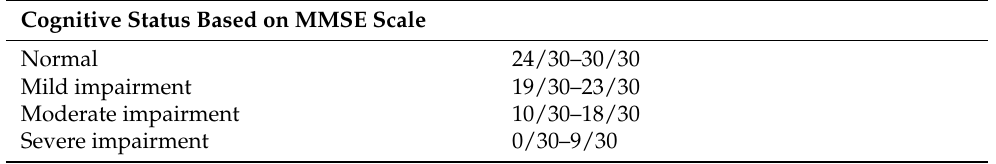
Table 2. Assessment criteria of cognitive status based on MMSE score (range 0–30).